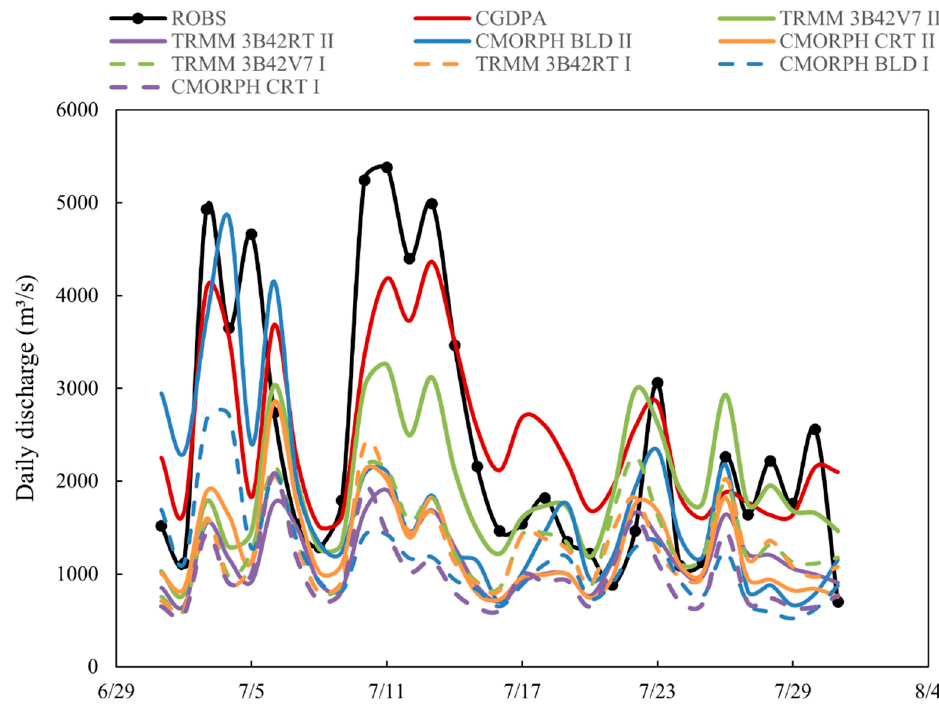
Figure 12. Observed and simulated extreme flood events under both Scenario I (dashed lines) and Scenario II (solid lines) during July 2013 on the Fujiang River basin.